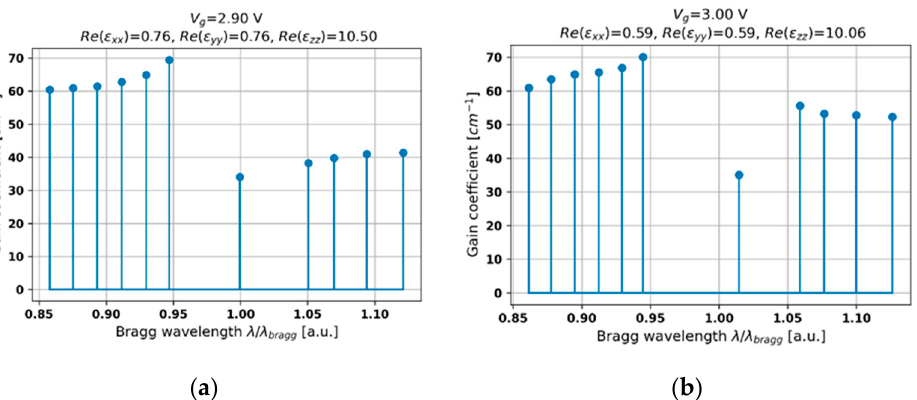
Figure 7. Threshold modal spectra for PHC structures with HMM structures revealing epsilon-near-zero dispersion and biased with external voltage V g = 2.9 V ( a ) and 3.0 V ( b ).